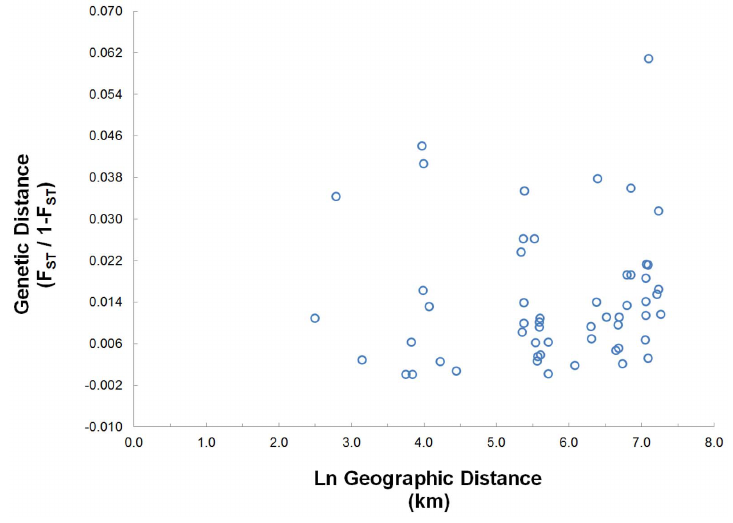
Figure 7. Isolation by distance between pairwise genetic versus pairwise geographical distances. Analyses used a reduced major axis regression (r 2 =0.006, intercept = 2 0.041 6 0.008, p=0.226) calculated from a Mantel test (r=0.076, p =0.314).